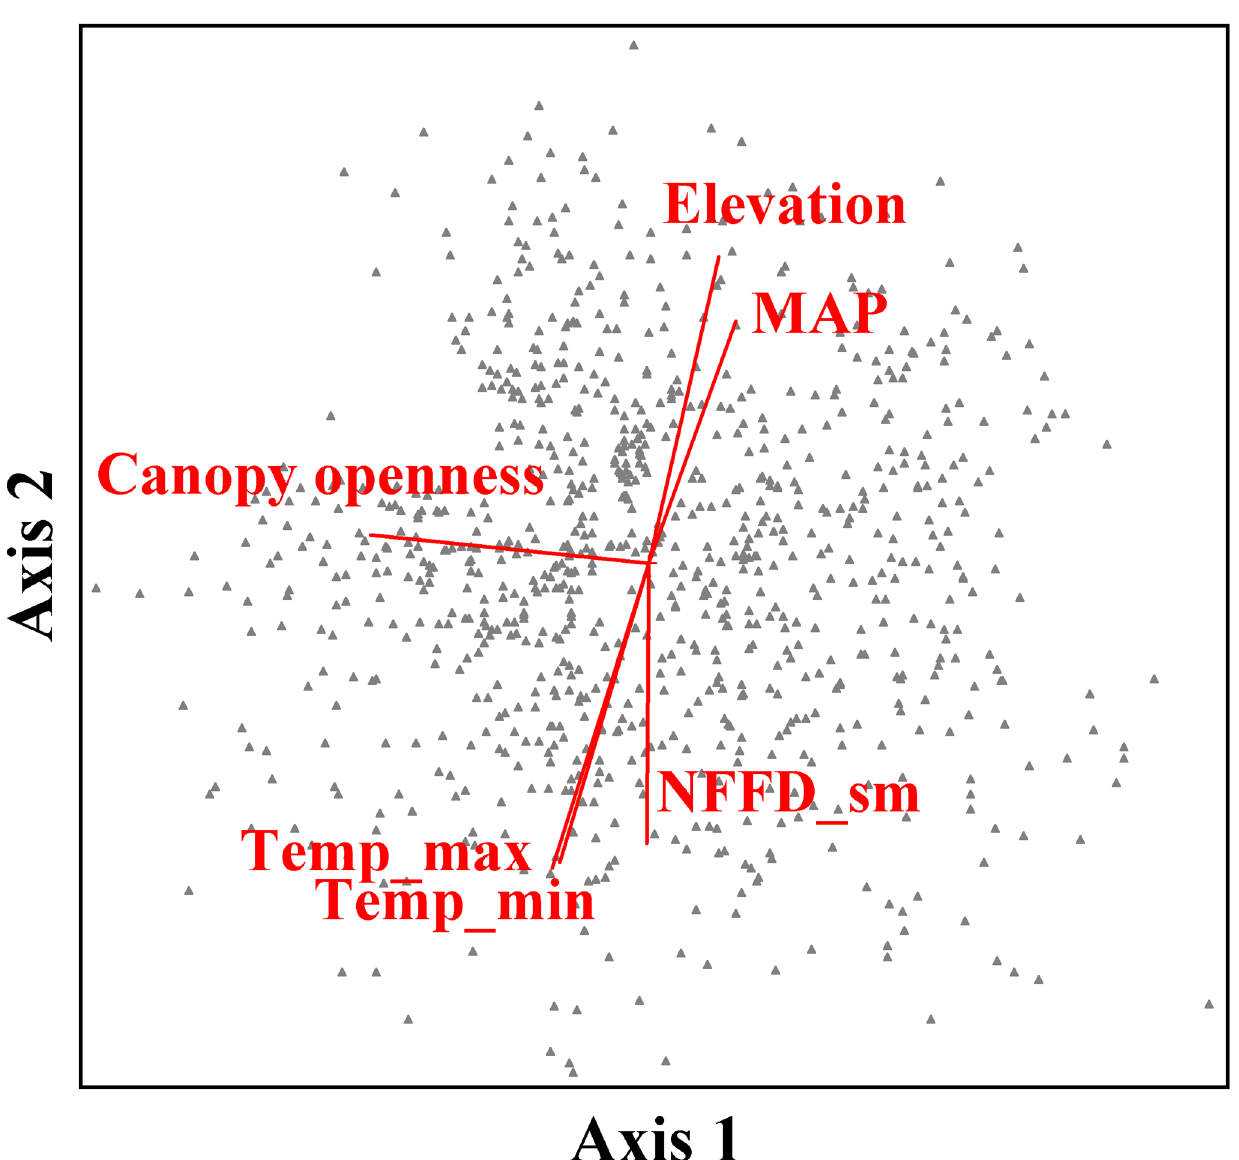
Fig 1. NMS joint plot of Wallowa Mountain plots in undergrowth plant community space. Vectors indicate direction and magnitude (length) of linear correlation between sample units in species space and environmental parameters. MAP (mean annual precipitation), Temp_max (mean annual maximum temperature), Temp_min (mean annual minimum temperature), NFFD_sm (mean number of frost free days in the